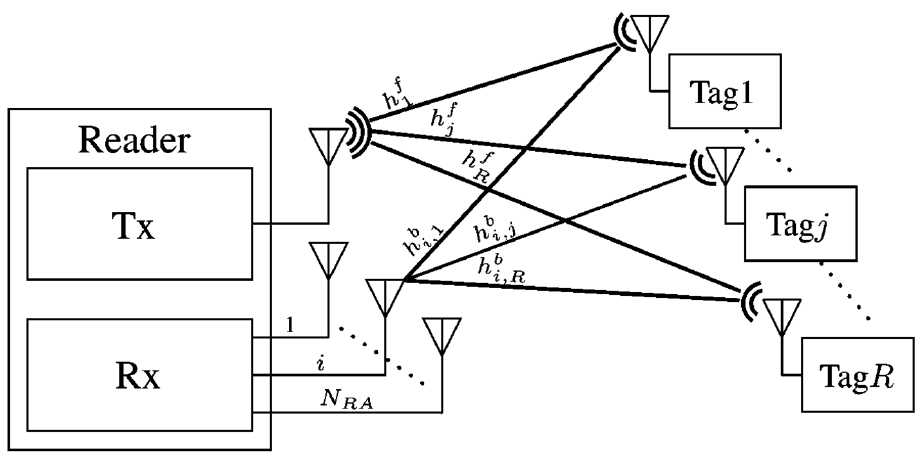
Figure 3. Architecture of the multi receive antenna RFID system. Reproduced from [31] with per- mission from IEEE.